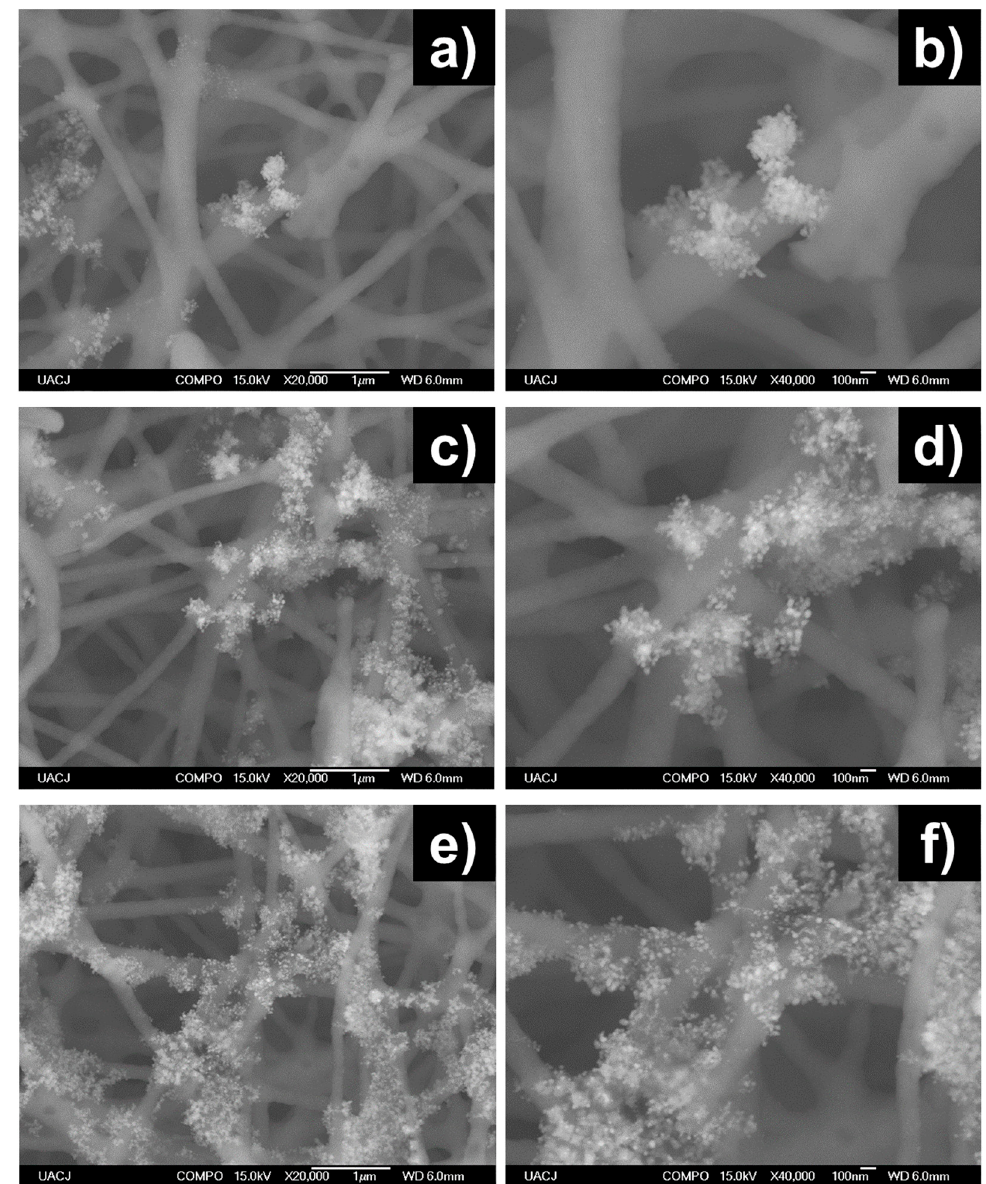
Figure 7. Micrographs of the SiO 2 –HA–Ag composite from supports F7 to F9: ( a ) F7 at 20,000× and ( b ) 40,000×; ( c ) F8 at 20,000× and ( d ) 40,000×, and ( e ) F9 at 20,000× and ( f ) 40,000×. 40,000 × ; ( c ) F8 at 20,000 × and ( d ) 40,000 × , and ( e ) F9 at 20,000 × and ( f ) 40,000 ×